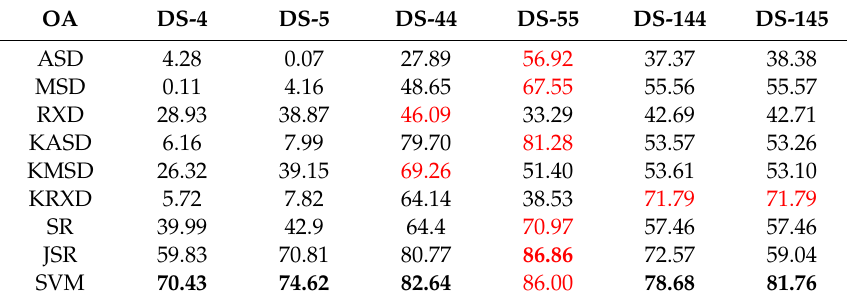
Table 3. Overall accuracy (OA) in percentage of each method and band combination. Red numbers indicate the best accuracy for each method and bold numbers indicate the best accuracy for each